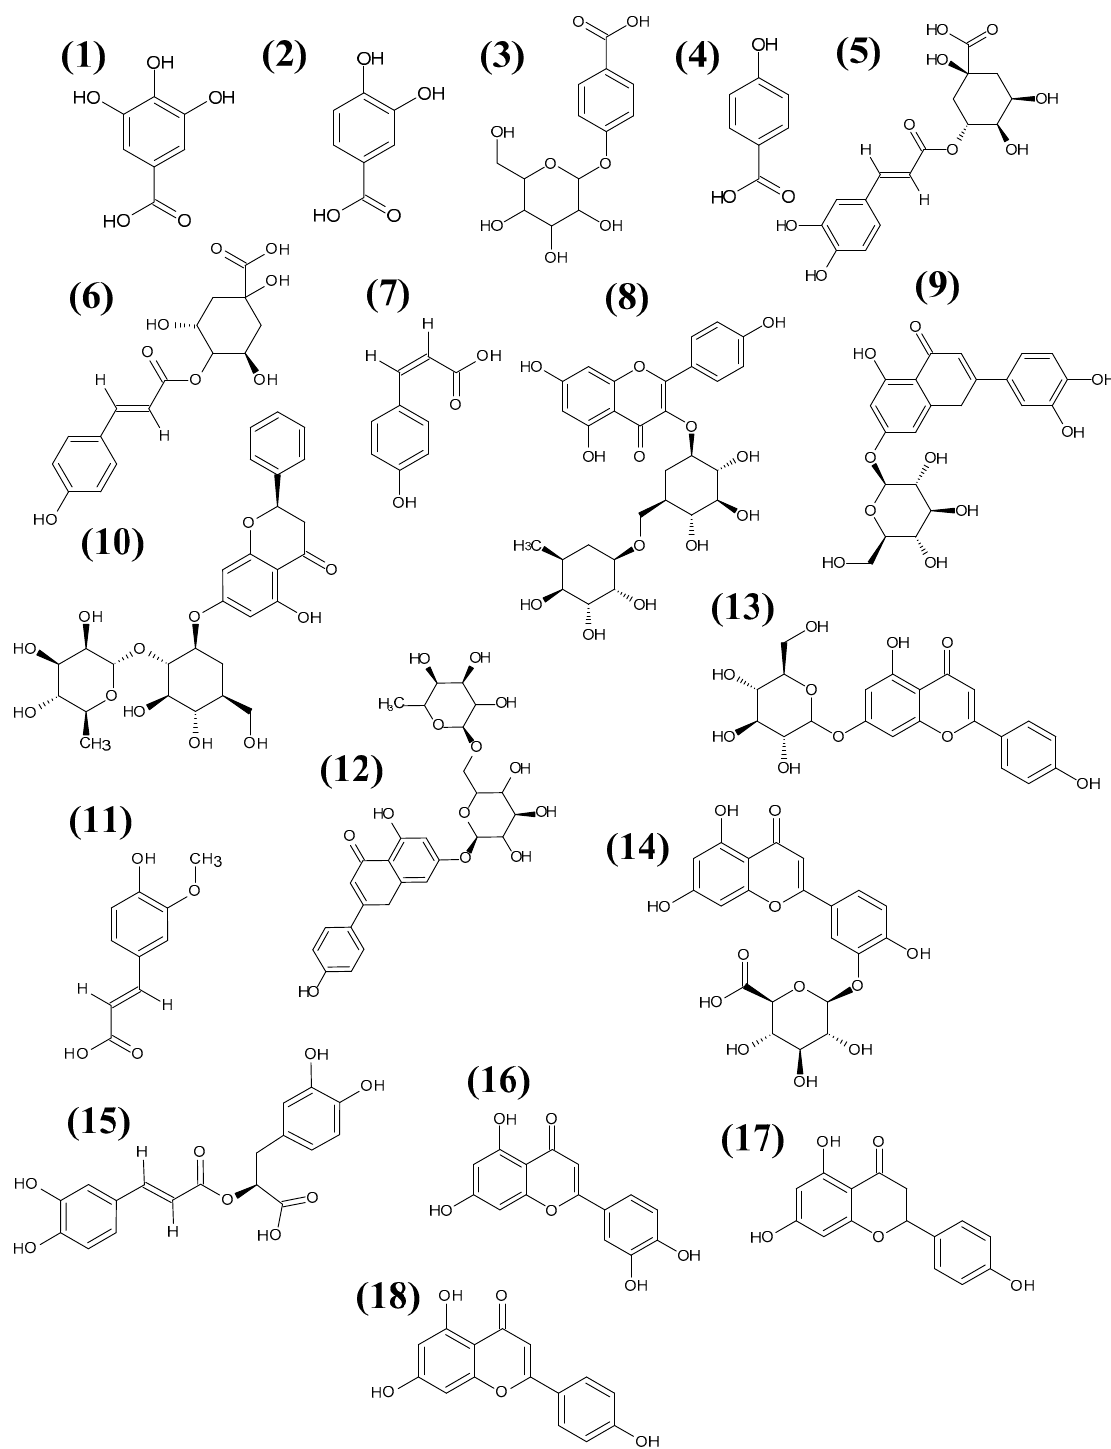
Figure 2. The chemical structures of the major components identified in the 70% methanolic extract from the flowering herbs of M. bradburiana : 1. Gallic acid, 2. Protocatechuic acid, 3. Hydroxybenzoic acid glucoside, 4. P -OH-benzoic acid, 5. Chlorogenic acid, 6. Coumarylquinic acid, 7. P -coumaric acid, 8. Kaempherol-3-rutinoside, 9. Luteolin-7-glucoside, 10. Naringin, 11. Ferulic acid, 12. Apigenin-7- rutinoside, 13. Apigenin-7-glucoside, 14. Luteolin-3-glucuronide 15. Rosmarinic acid, 16. Luteolin, 17. Naringenin, 18. Apigenin.